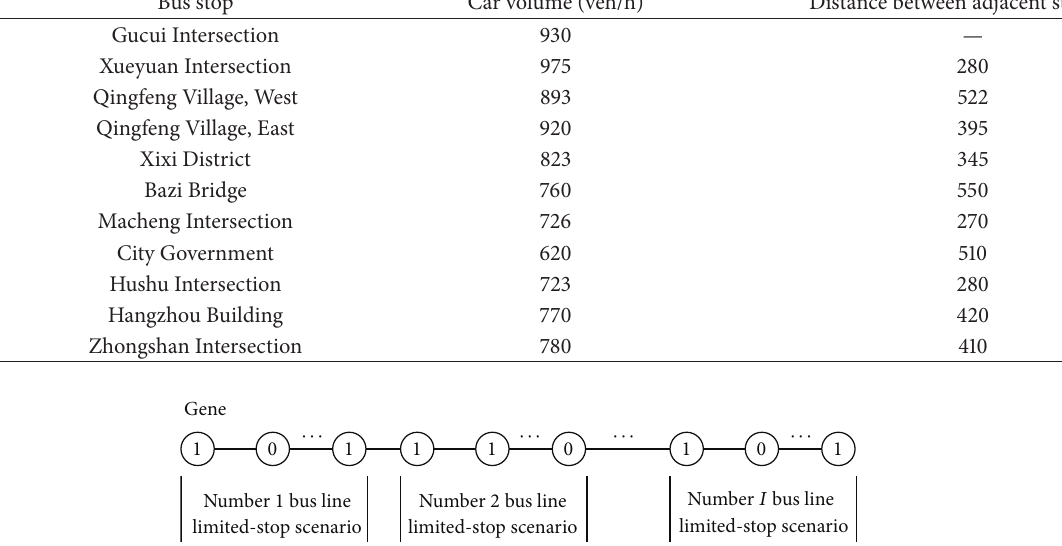
Figure 3: The coding illustration of a chromosome for the genetic